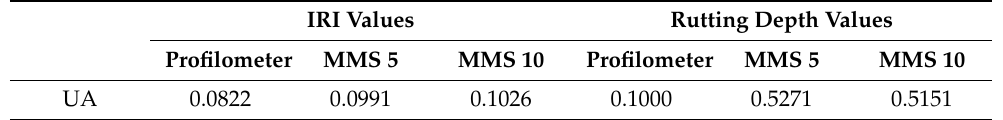
Table 2. Uncertainty analysis